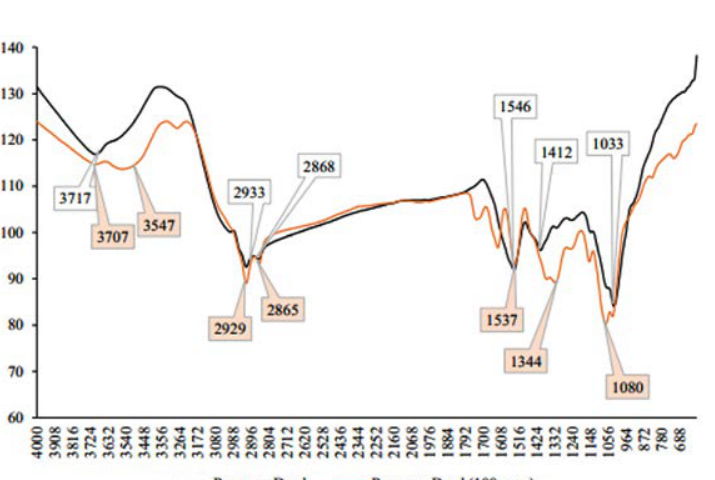
Fig. 5 . FTIR data of dead cells of R. oryzae before and after the absorption in 100 ppm Hg 2+